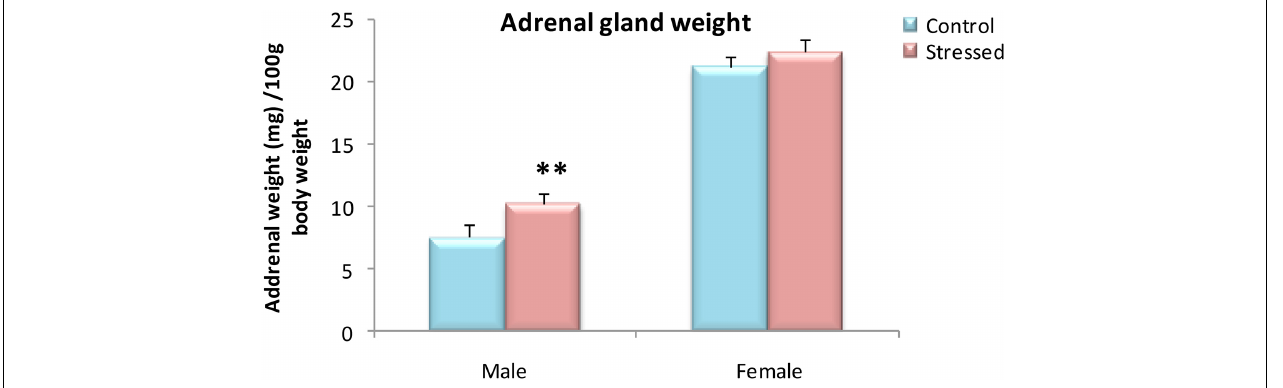
FIGURE 1 | Variation in adrenal weight relative to body weight (mg/100 g of body weight) of control and stressed rats of both sexes. In males, cold stress significantly increased relative adrenal weight in the stressed group compared to the control group. In females, exposure too cold for 5 days had no effect on adrenal glands weight. Adrenal glands weight is expressed in (mg) per 100 g of body weight. Data are represented as mean ± SEM ( n = 5) for each sex. Effect of stress: ∗∗ P = 0.001.